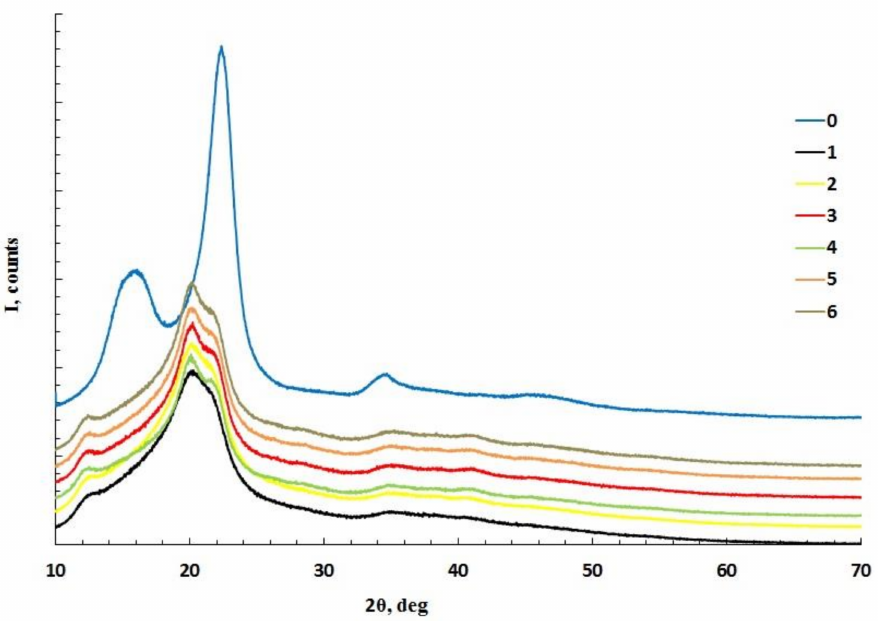
Figure 1. Diffractograms of microcrystalline cellulose (0) and cellulose cryogel samples (numbers according to Table